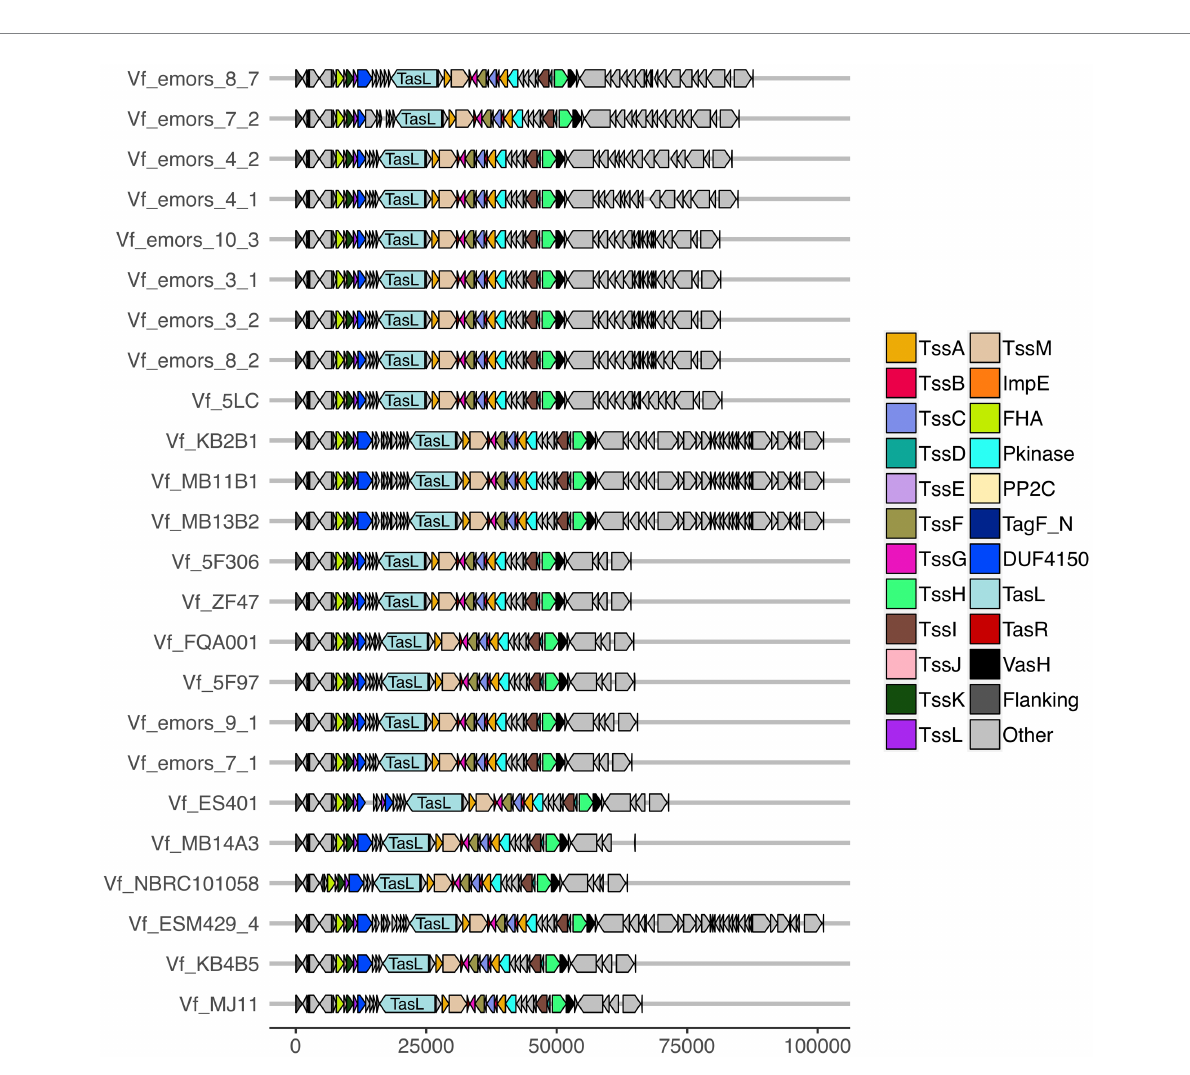
FIGURE 4 Predicted T6SS2 clusters of Vibrio fischeri genomes feature different patterns of cluster expansions. Gene organization of the predicted T6SS2 clusters of both fish and squid symbiont and environmental V. fischeri genomes. Genes labeled as “other” do not currently have a documented T6SS-associated function. See Supplementary Table S6 for a list of predicted annotations for proteins labeled as “other.” Genes are drawn to scale at bottom of figure, measured in